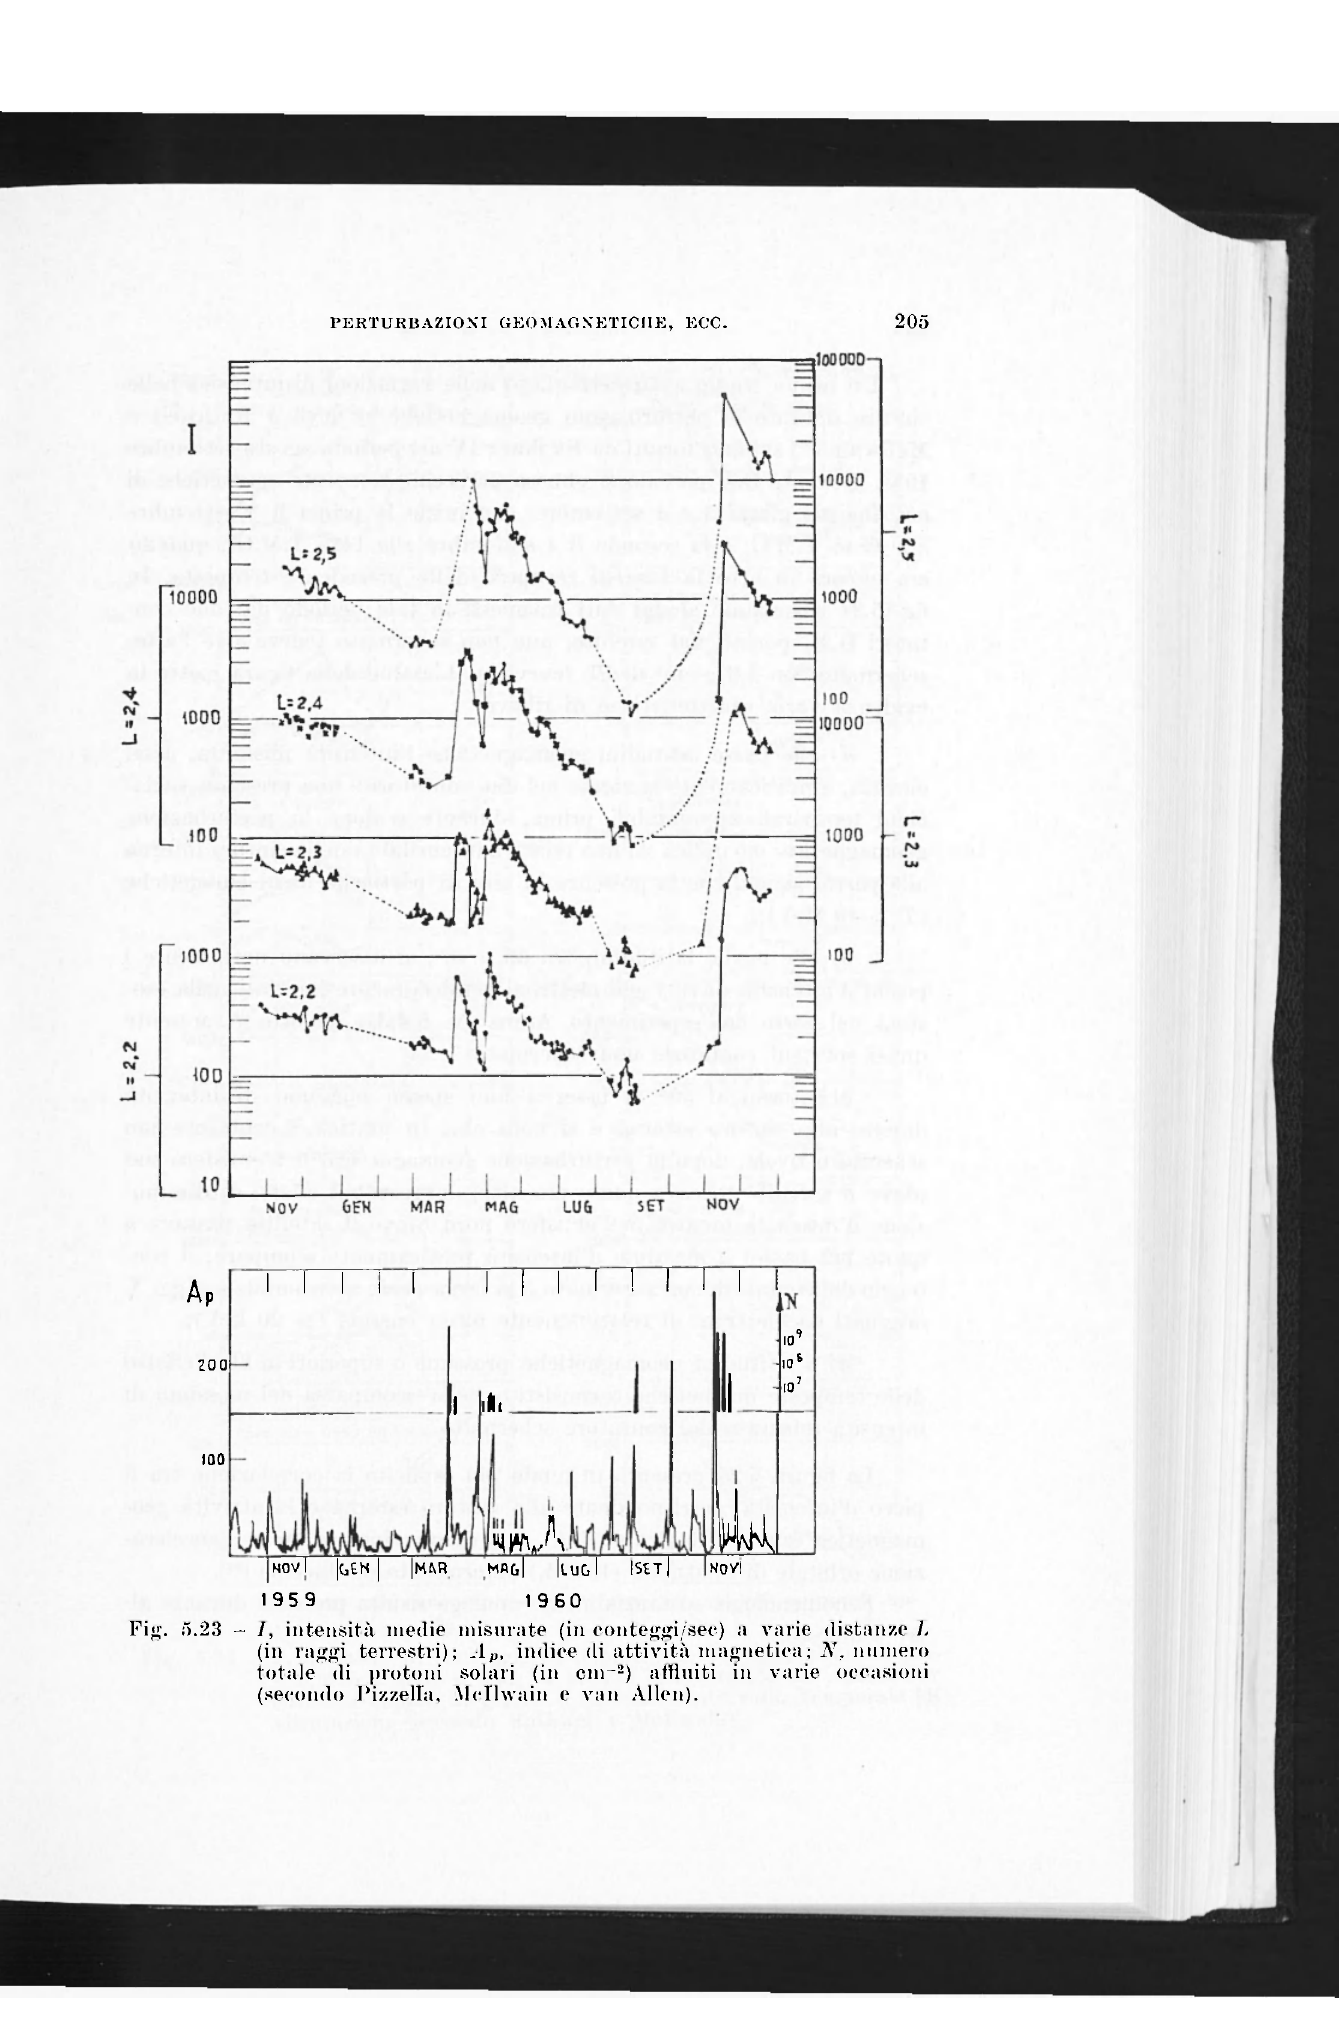
Fig. 5.23 - /, intensità medie misurate (in conteggi/sec) a varie distanze L (in raggi terrestri); A p , indice di attività magnetica; N, numero totale di protoni solari (in cm- 2 ) affluiti in varie occasioni (secondo Pizzella, Mcllwain e van